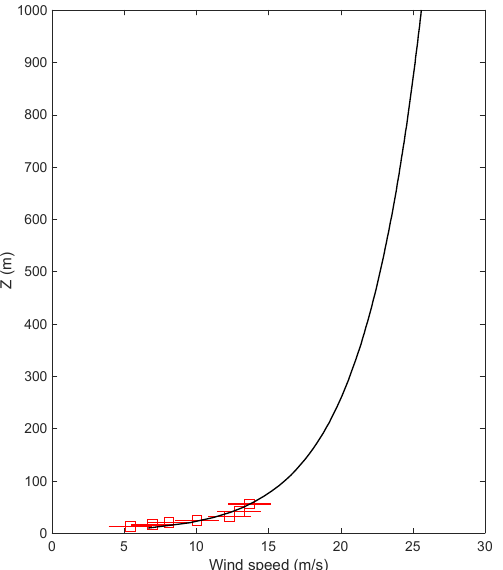
Figure 3. Inflow profile for the Aeolus model (black line) overlaid with field data from site RS (red squares are the time averaged values and the red line represent the variance). Figure 4 shows the turbulent structures in the velocity magnitude in a vertical slice along lines A and AA. The velocity magnitude increases as it passes over the Askervein Hill top and the flow separates in the lee side of the hill. It can be observed that a larger wake is created behind the plane passing along line A. This larger region of separation occurs due to a steeper drop in elevation along line A and has been observed in other model results, as well as observed data. Winds were simulated for 2 h, which took about 6 h of computer time on a quad ‐ core machine. After a 1.5 h spinup period, Aeolus data from the last 30 min of the simulation was time averaged for comparision with the observed data.